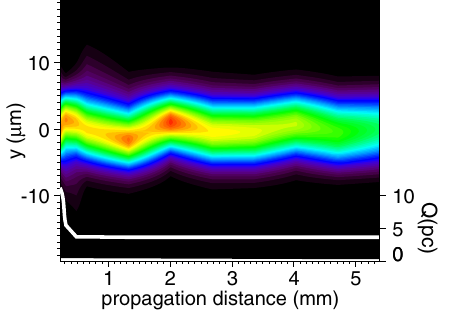
FIG. 11. Laser transverse intensity profile as a function of propagation distance for pulse 1 in a plasma channel with matched ¼ 9 . 2 μ m. The white line represents the trapped charge spot w M (right y